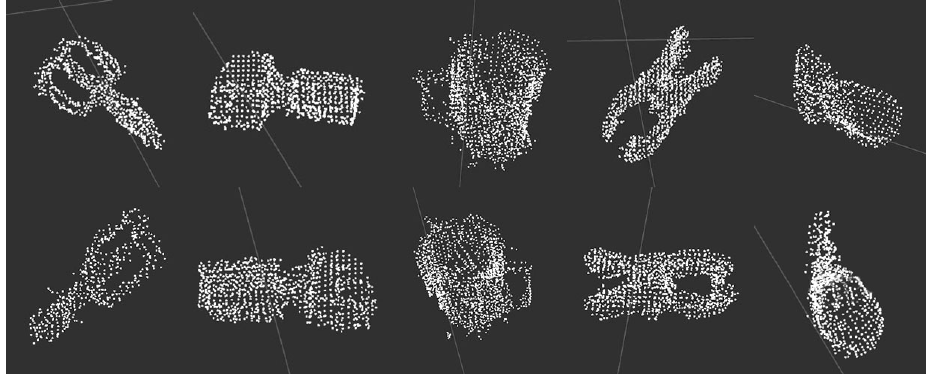
Figure 7. Acquired 3D point cloud data of manipulation objects.